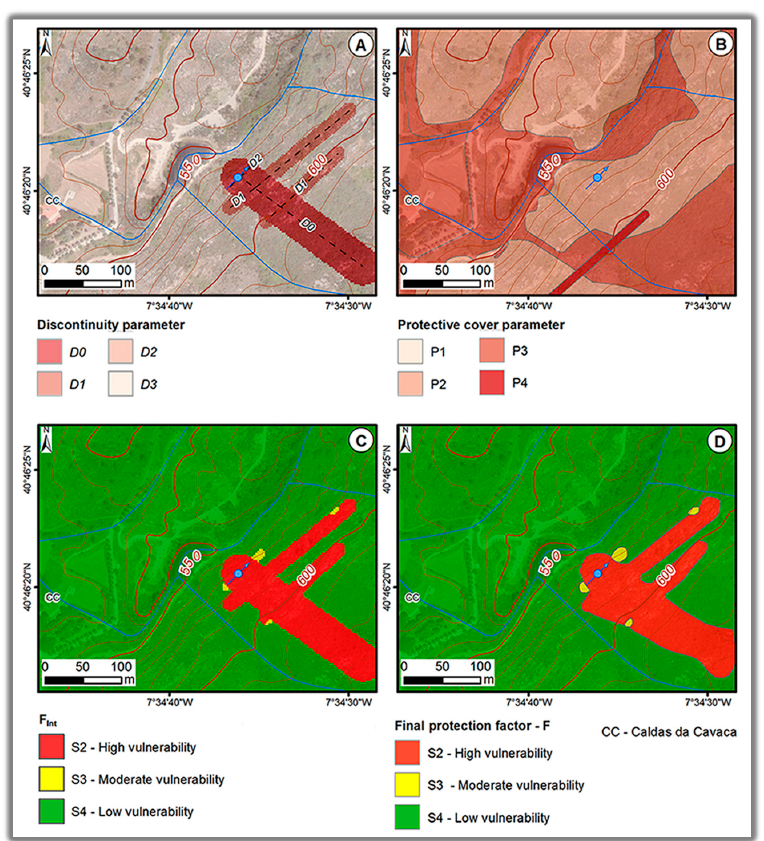
Figure 8. DISCO method applied to a spring at the Caldas da Cavaca site: ( A ) discontinuity parameter; ( B ) protective cover parameter; ( C ) intermediate protection factor ( F int ); ( D ) final protection factor ( F 2.